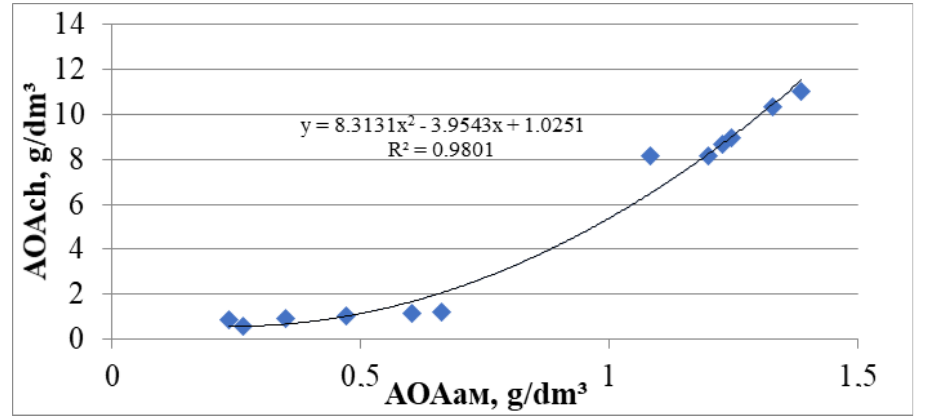
Figure 2. Correlation of amperometric and chemiluminescent methods for determining the AOA of white and red table wine materials.